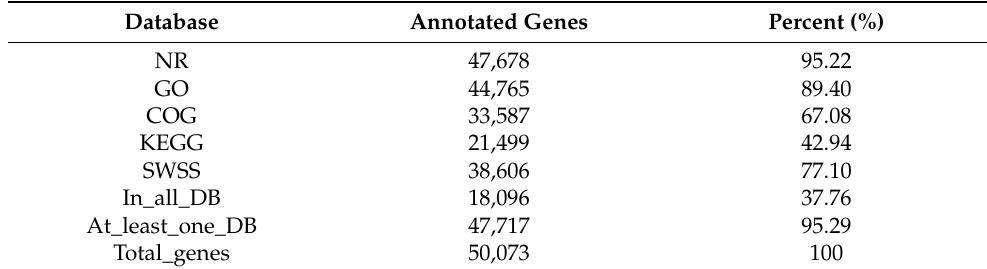
Table 3. Functional annotation of reconstructed